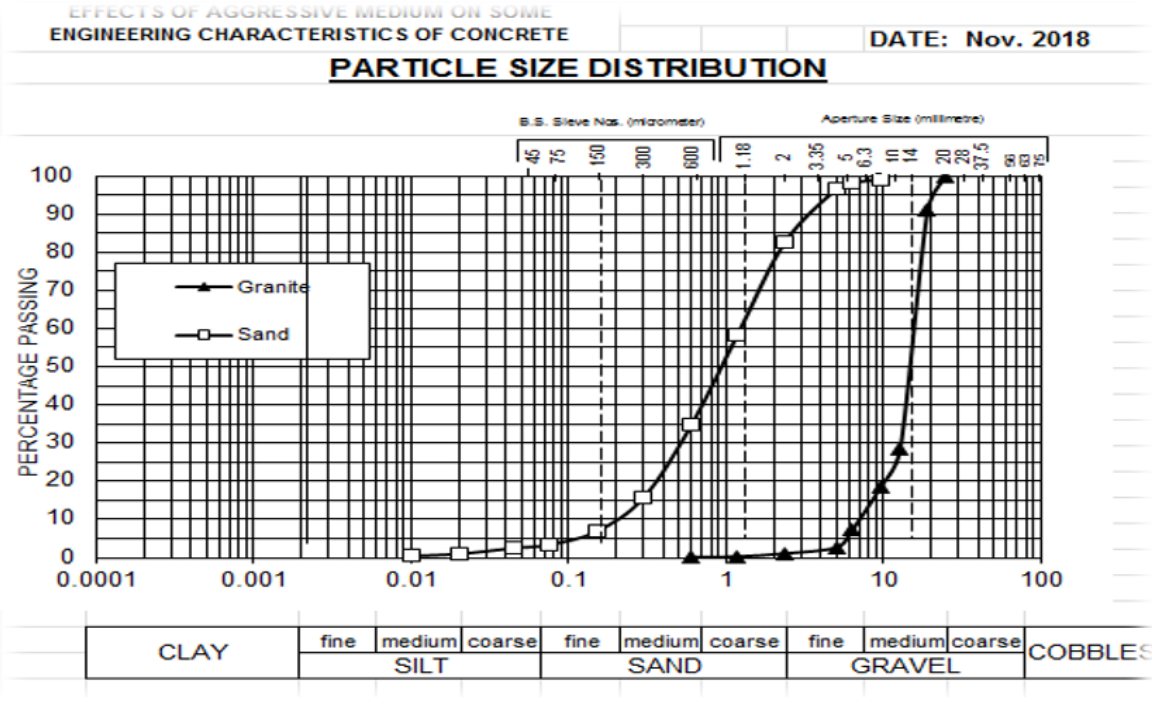
Figure 2. Particle size distribution curves for fine and coarse